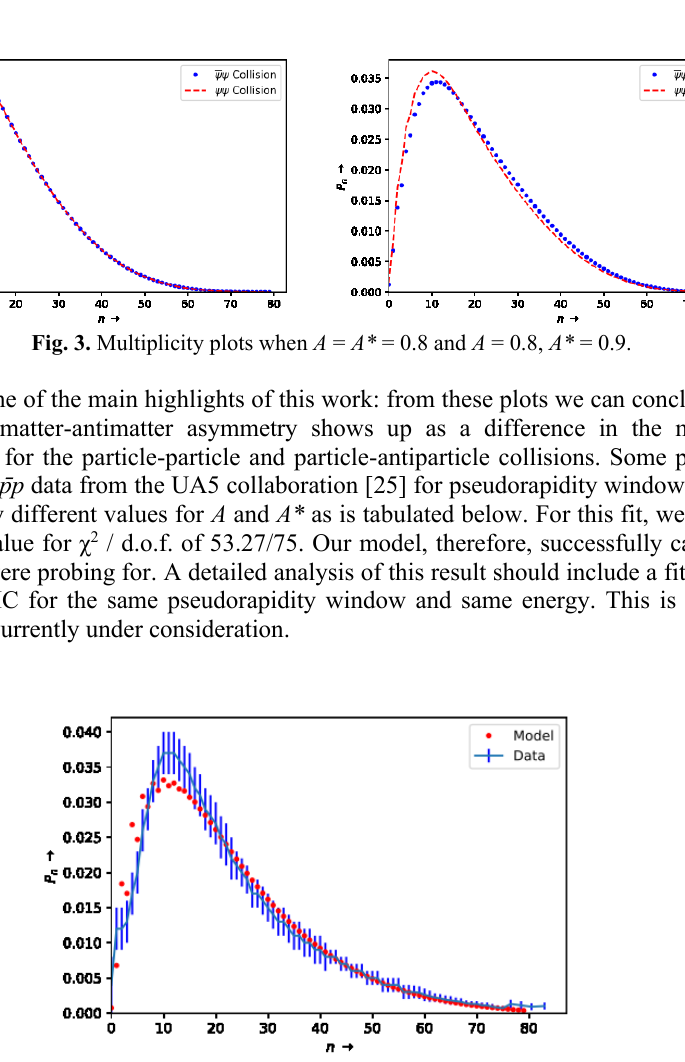
Fig. 4. Preliminary fit of our model to data from UA5 at √ s = 900